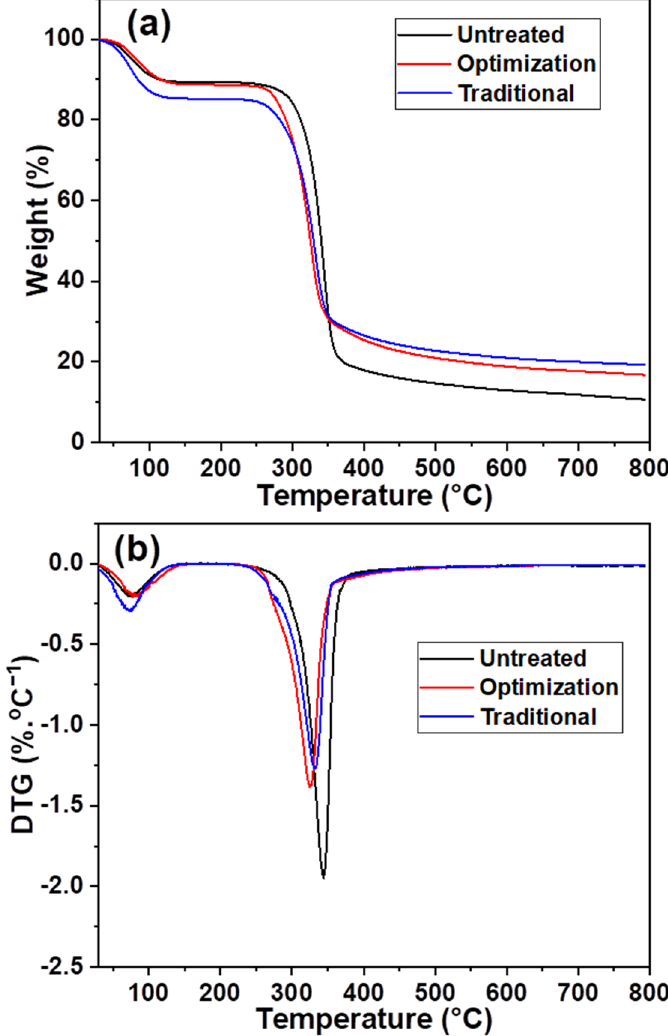
Figure 7. Effects of different chlorine dioxide oxidation conditions on thermal stability of the eucalyptus fiber ( a ), variation of weight loss in different eucalyptus fibers; ( b ), variation of weight loss rate in different eucalyptus fibers.